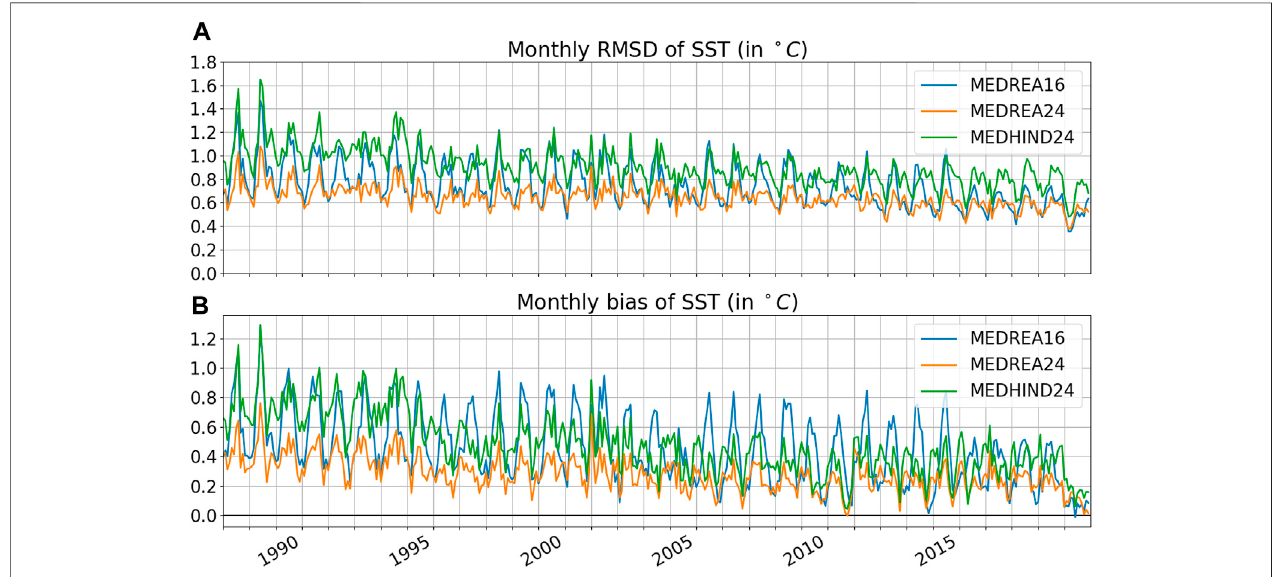
FIGURE4 | Monthly RMSD (A) and bias (B) of SST(in ° C ) for the two reanalyses and the hindcast when compared to satellite SST. The fi rst model layer isused for the model SST.